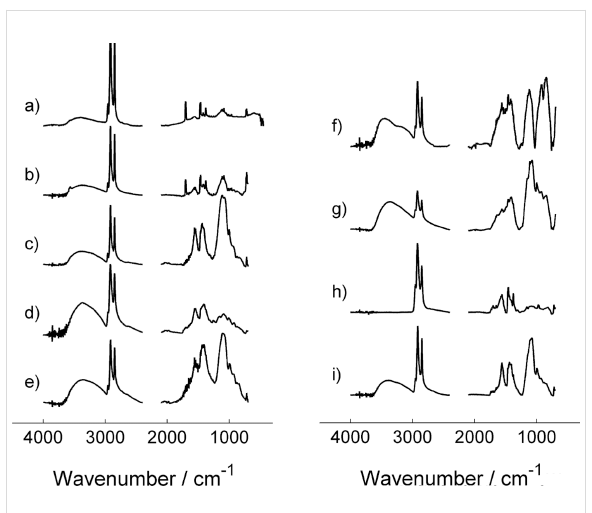
Figure 6: FTIR-ATR spectra of MnS NCs (selection of significant ranges). Left: spectra of NCs prepared using MnSt 2 as a precursor with S/Mn = 2 and L/Mn = 4; L = StAc (a), DdTh (b), HdAm (c), OlAm (d), OlAm/DdTh 1:1 mixture (e). Right: spectra of NCs prepared using Mn 2 (CO) 10 as a precursor with S/Mn = 2. Spectra (f) and (g) corres- pond to NCs prepared with amine surfactant only (L/Mn = 4:1); L = HdAm (f), OlAm (g). Spectra (h) and (i) correspond to NCs prepared using a mixture of StAc (L acid /Mn = 2:1) and amine surfac- tant (L amine /Mn = 4:1); L amine = HdAm (h), OlAm